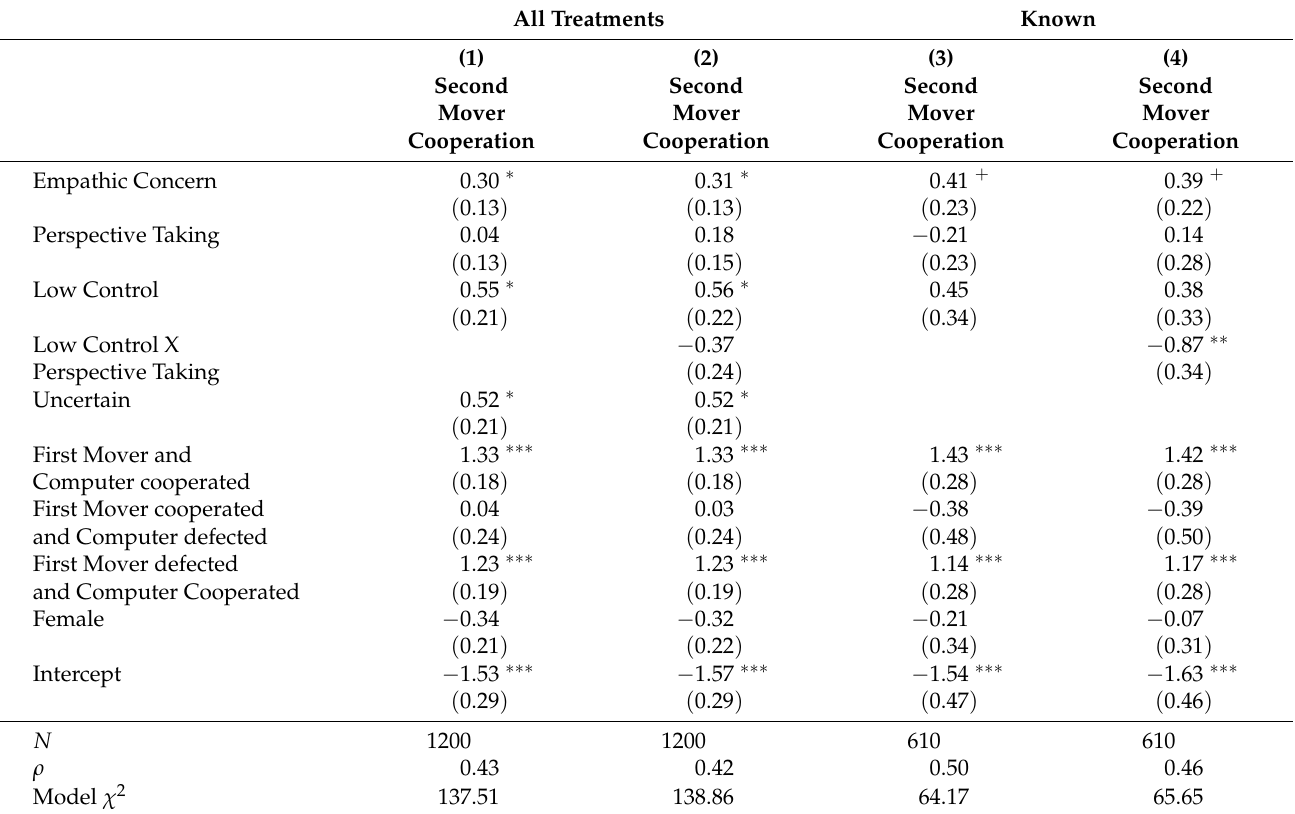
Table 4. Second Mover Cooperation with Empathy and Perspective Taking (First 10 Rounds).